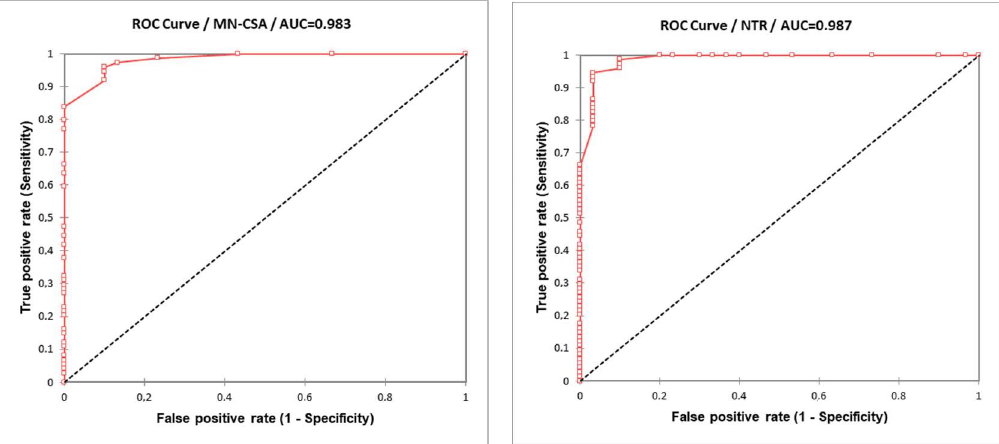
Figure 3. ROC curves obtained comparing each US parameter (MN-CSA and NTR) in the clinical diagnosis of CTS (as gold standard).